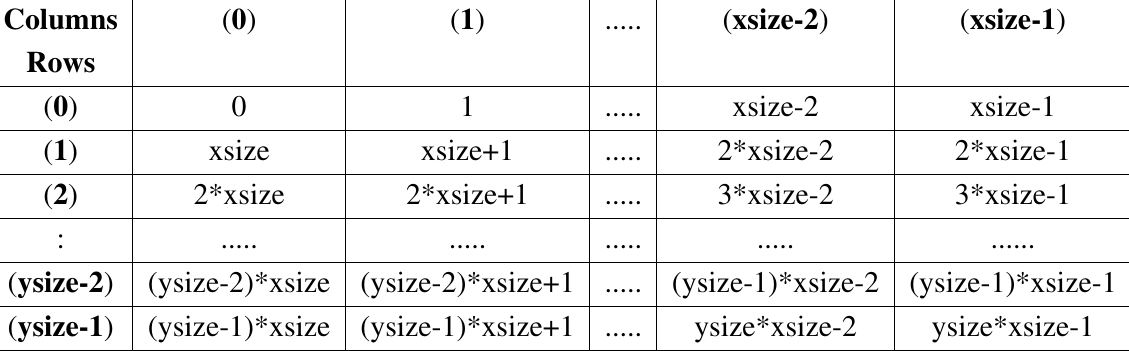
Table 2. Indexes of the receptor matrix elements: ysize stands for rows and xsize for